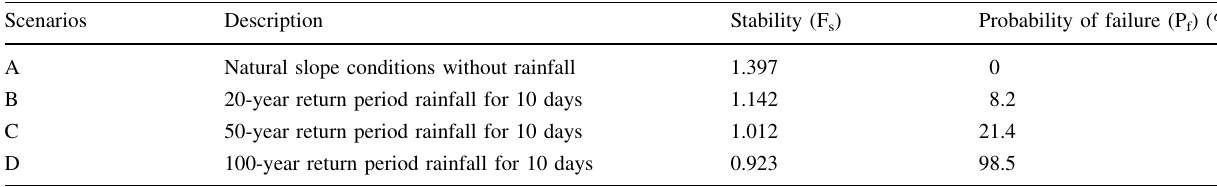
Table 2 Slope stability and probability of failure for the four scenarios